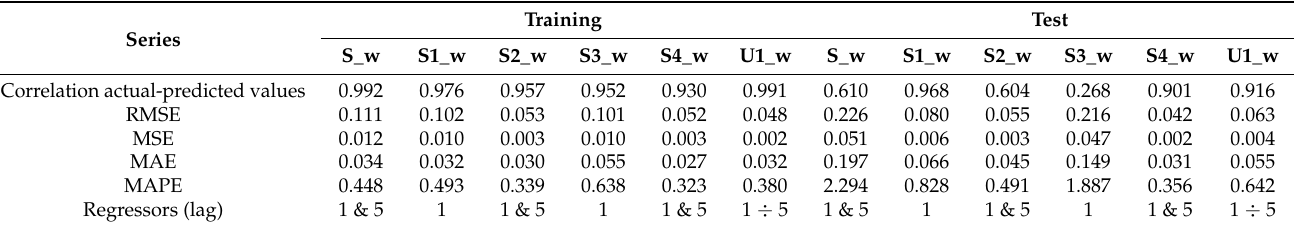
Table 14. Performances of the best models built for S_w and its subseries.